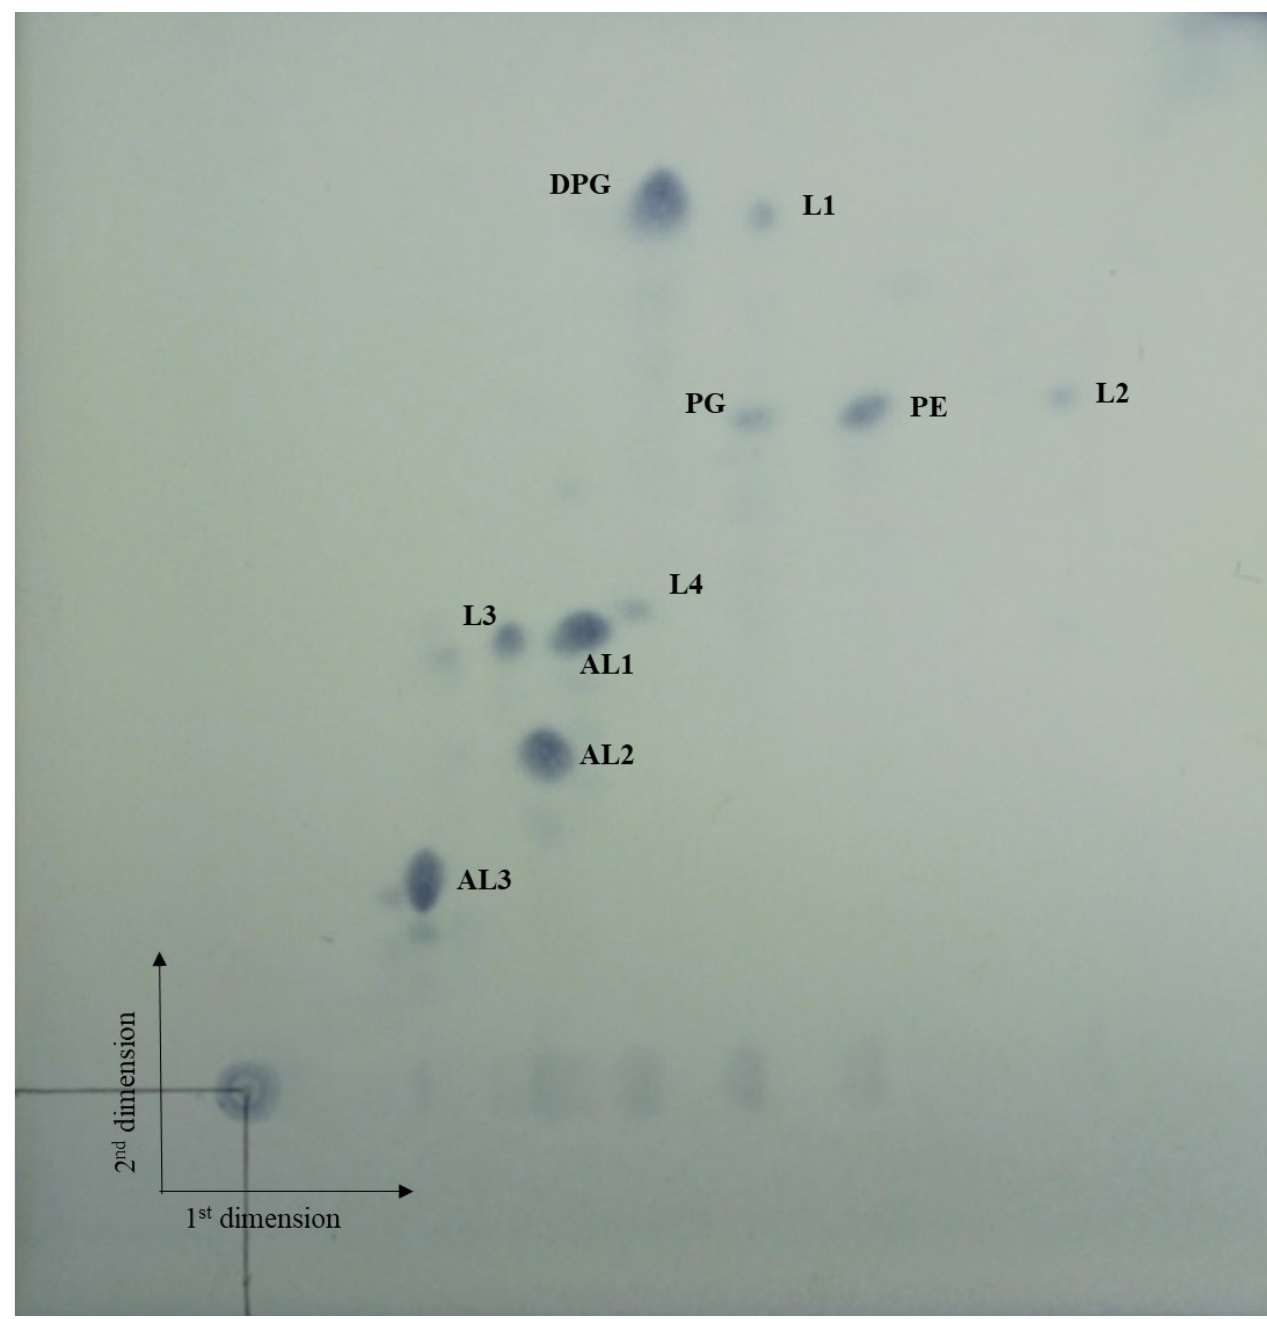
Figure 2. TLC of the polar lipids of strain AN120528 T . Spots were stained with 5% ethanolic molybdophosphoric acid.